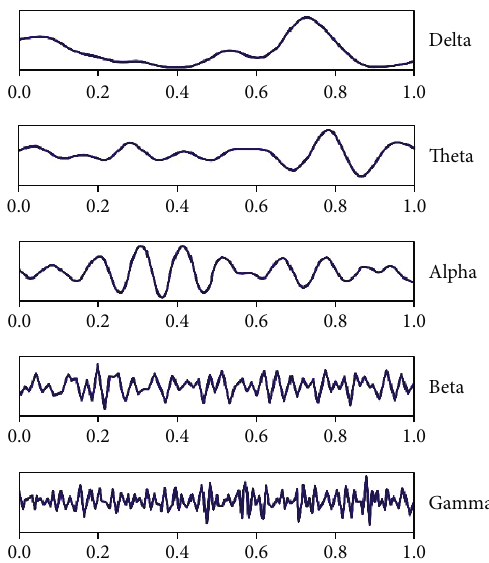
Figure 1: Quantitative electroencephalography (qEEG). qEEG is a reliable measure of neurophysiological electric activity. qEEG measures activity of the brain, usually in the resting state, and is sensitive to changes in synaptic function and network connectivity [12]. The fi ve distinct frequency bands that can be analyzed with qEEG have unique brain function associations: delta ( < 4 Hz) is associated with deep sleep; theta (4 – 8 Hz) correlates with rapid eye movement (REM) sleep and quiet wakefulness, as well as aspects of memory and language processes; alpha (8 – 14 Hz) is related to suppression of task-irrelevant activity during “ idle ” cognitive processing; beta (14 – 30 Hz) is associated with arousal, alertness, and voluntary movement; and gamma ( > 30 Hz) is most relevant to cognitive function and attention. The e ff ects of drug candidates on qEEG lend themselves ideally to detect changes in the saliency network, which is particularly useful in neurodegenerative and neuropsychiatric conditions with cognitive impairment [124]. Furthermore, qEEG is translatable from animal models of disease to humans; hence, qEEG can be used as the fi rst step in narrowing the dose of a drug by correlating the pharmacokinetics and pharmacodynamics of the drug to changes in qEEG [14]. For example, auditory EPs can be used to correlate antidepressant and antipsychotic responsiveness in animal models to humans [14]. Correlating qEEG changes with drug doses can lessen the need to de fi ne doses based on psychometric outcomes and the associated risk; de fi ning these doses typically requires larger and longer clinical trials, and results are highly